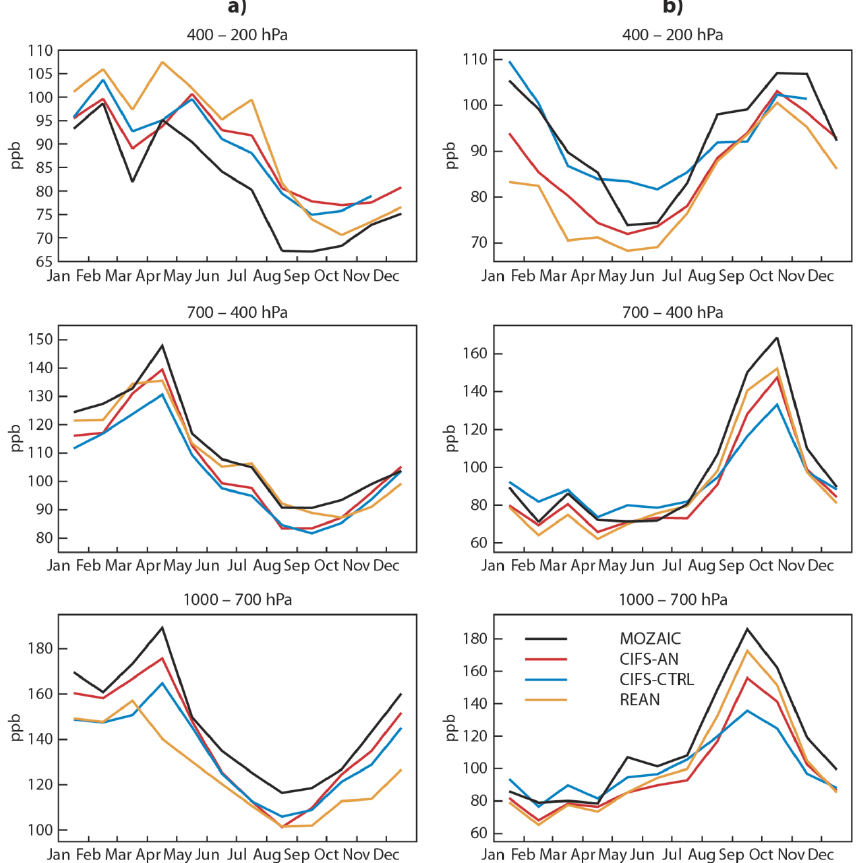
Figure 5. Time series of monthly mean tropospheric CO in ppb over (a) Frankfurt (50 ◦ N, 8.6 ◦ E, 837 profiles) and (b) Windhoek (22.5 ◦ S, 17.5 ◦ E, 323 profiles) averaged in the pressure bands 1000–700hPa (bottom), 700–400hPa (middle) and 400–200hPa (top) from MOZAIC aircraft data (black), CIFS-AN (red), CIFS-CTRL (blue) and REAN (orange) in